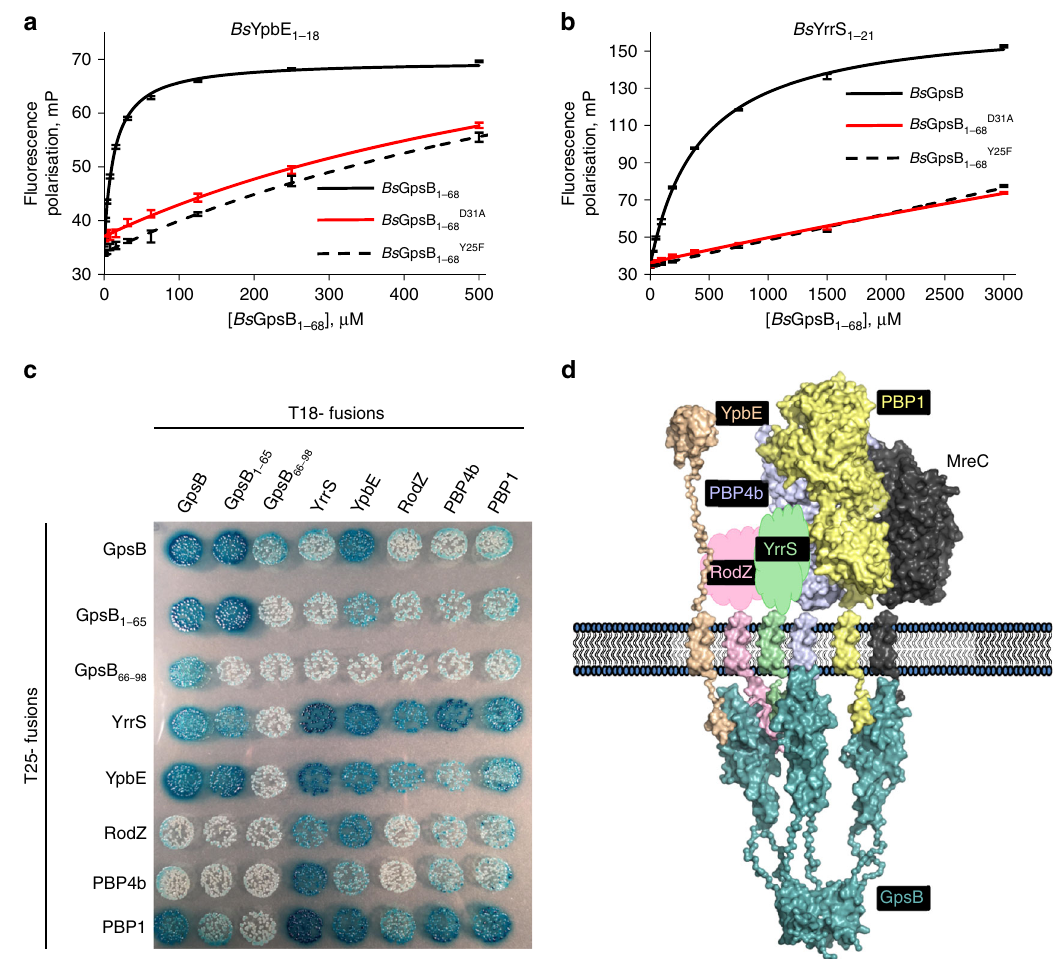
Fig. 3 The SRxxR(R/K) motif identi fi es Bs YpbE and Bs YrrS as new Bs GpsB binding partners. a , b Bs YpbE 1-18 and Bs YrrS 1-21 bind to Bs GpsB 1-68 at the same site as Bs PBP1. Fluorescence polarisation of Bs GpsB 1-68 binding to fl uorescein-labelled Bs YpbE 1-18 ( a ) and fl uorescein-labelled Bs YrrS 1-21 ( b ). The interaction of wild-type proteins is depicted by black curves, whereas the red curves and dashed black lines correspond to Bs GpsB 1-68 Asp31Ala and Bs GpsB 1-68 Tyr25Phe mutants, respectively. c BACTH reveals a new Bs GpsB interaction network involving proteins encoding the SRxxR(R/K) motif. The panel shows pairwise combinations of proteins expressed as N-terminal fusions to both halves of adenylate cyclase in the BACTH host strain. Their presence in complexes containing Bs RodZ, Bs PBP4b and Bs PBP1 imply roles for Bs YrrS and B sYpbE in sidewall synthesis during cell growth. The validity of the observed interactions is supported by the behaviour of the T18-GpsB 66-98 fusion, which does not interact with any other partner except T25-GpsB, and therefore acts as an internal control. The T18- Bs GpsB 66-98 :T25- Bs GpsB interaction is consistent with the hexameric nature of Bs GpsB 19,26 . The absence of interactions between Bs GpsB 66-98 and Bs YrrS or Bs YpbE is consistent with data in b that shows that the N-terminal domain of GpsB interacts with the SRxxR(R/K) motif of YpbE and YrrS. d A model recapitulates interactions between Bs GpsB and partners. Surface representations of the SAXS structure of Lm GpsB 26 (coloured teal) and the closest homologues in the PDB by sequence ( Bs PBP1, yellow, PDBid 2OLV; Bs PBP4b, pale blue, 4L0L; Bs RodZ, pink, 2WUS; Bs MreC, dark grey, 2J5U; Bs YpbE, salmon, 2MKX and the linker represents the disordered region, residues 131-188) are used as models for the B. subtilis proteins. Amorphous blobs, the surface area of which are scaled proportional to molecular weight, are used for Bs YrrS (green) and the extracellular domain of Bs RodZ (pink) where there is no structural information. The N-terminal domain of each membrane protein is cytoplasmic and 22-amino acid model helices represent each TM helix. The TMpred-predicted TM boundaries are: Bs PBP1 (38-60); Bs PBP4b (9-31); Bs YrrS (19-41); Bs YpbE (57-79); Bs RodZ (89-111) and Bs MreC (7-24). The GpsB-interacting domains of Bs YpbE, Bs YrrS and Bs PBP1 are based on the Bs PBP1 1-17